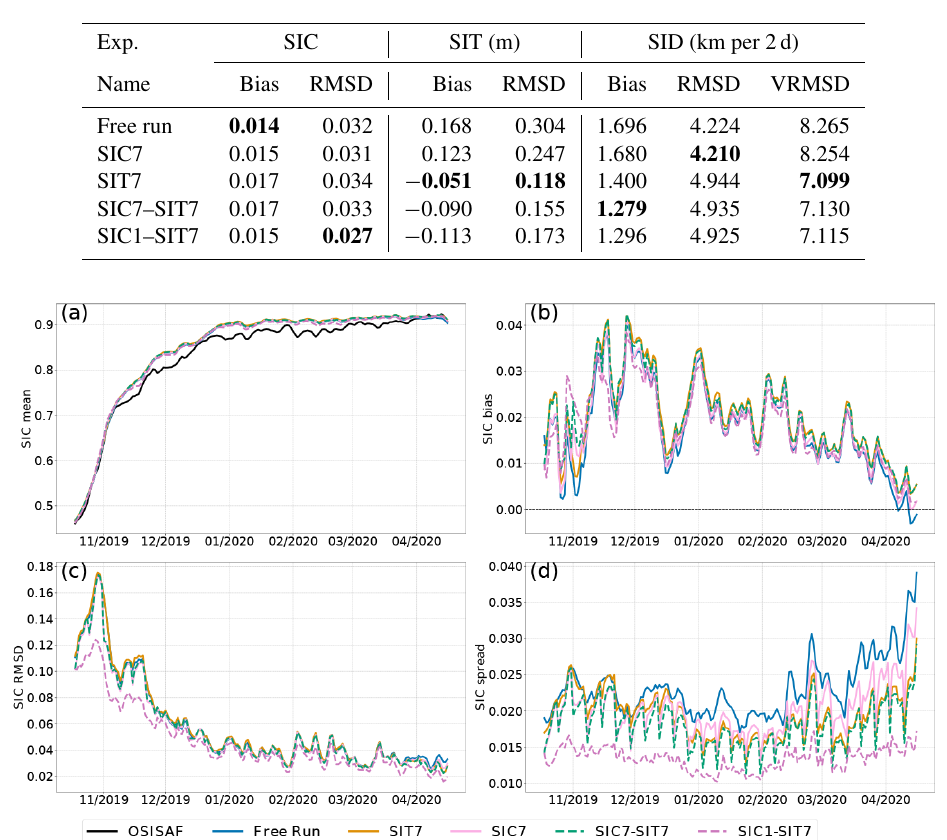
Table 2. Summary of the metrics for SIC, SIT, and SID: spatiotemporal averaged bias, RMSD, and VRMSD among the experiments. SIC is validated against OSI-SAF SIC, SIT is validated against CS2SMOS SIT, and SID is validated against OSI-SAF SID. The best value of each ice feature among the experiments is bolded.